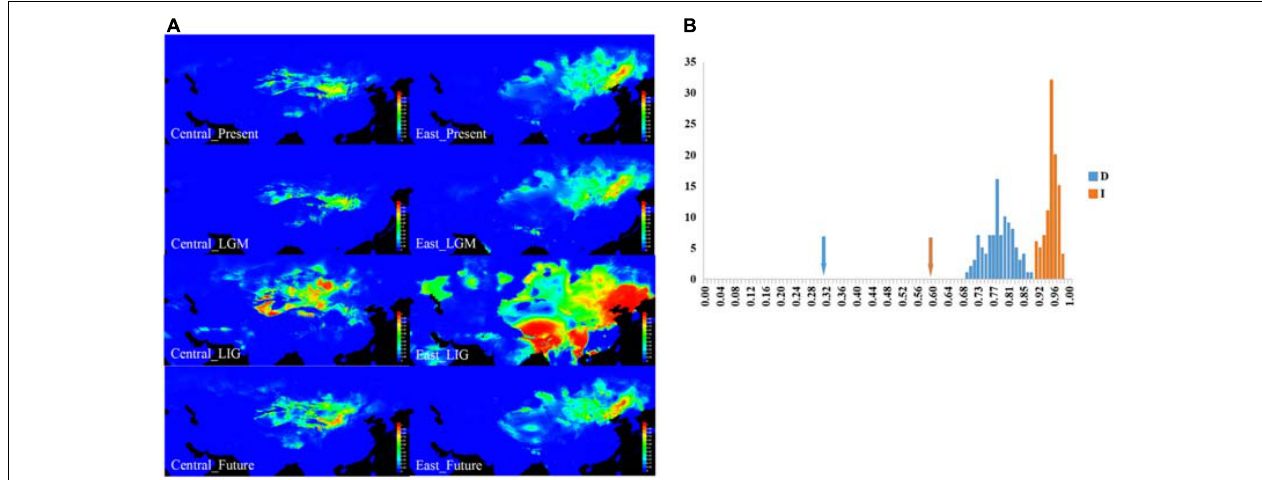
FIGURE 4 | The results for ecological niche modeling suggest three significant divergent niches of sand rice. (A) Geographic projections of the Central and East lineages of sand rice niche derived from the MaxEnt model. These figures originated from the software packages of MAXENT version 3.3.3, the environmental variables originated from the WorldClim database version 1.4 (1950–2000, http://www.worldclim.org/) and then modified by CQ with CorelDraw X6 (Corel Corporation, Ottawa, ON, Canada). (B) Results of identity tests. Observed niche overlap values of Schoener’s D and I for Central and East lineages compared to null distributions (bars indicate the null distributions of D or I ). All pairwise comparisons show significant niche divergence ( P <